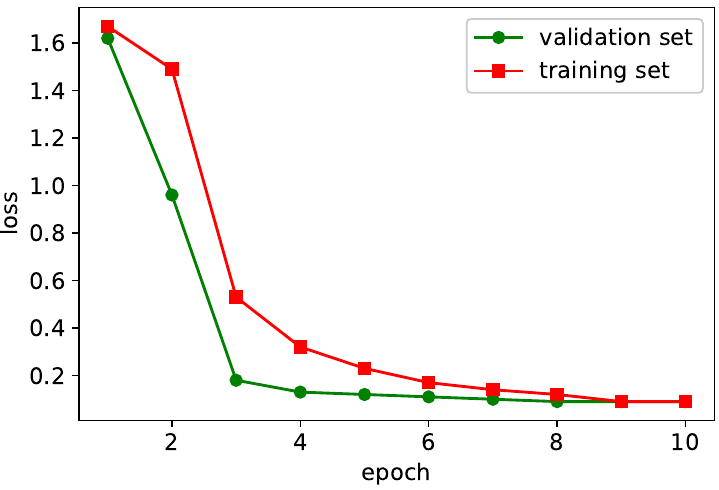
Figure 4. The loss curve of the feature fusion detection model on the validation set and training set.